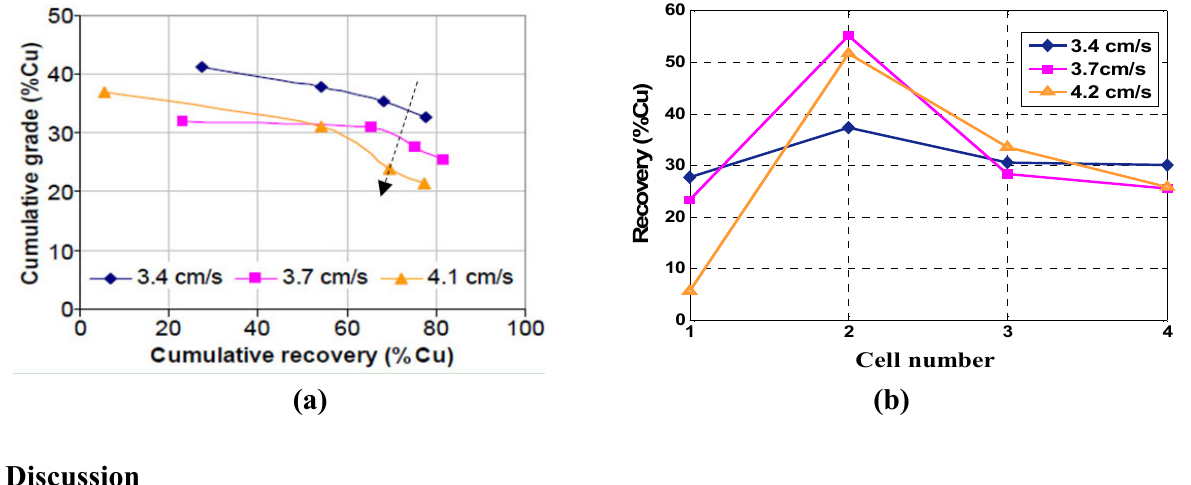
Figure 12. ( a ) Grade-recovery curves for three increasing air rate profiles at three total air rates [23]; ( b ) Corresponding cell-by-cell Cu recovery